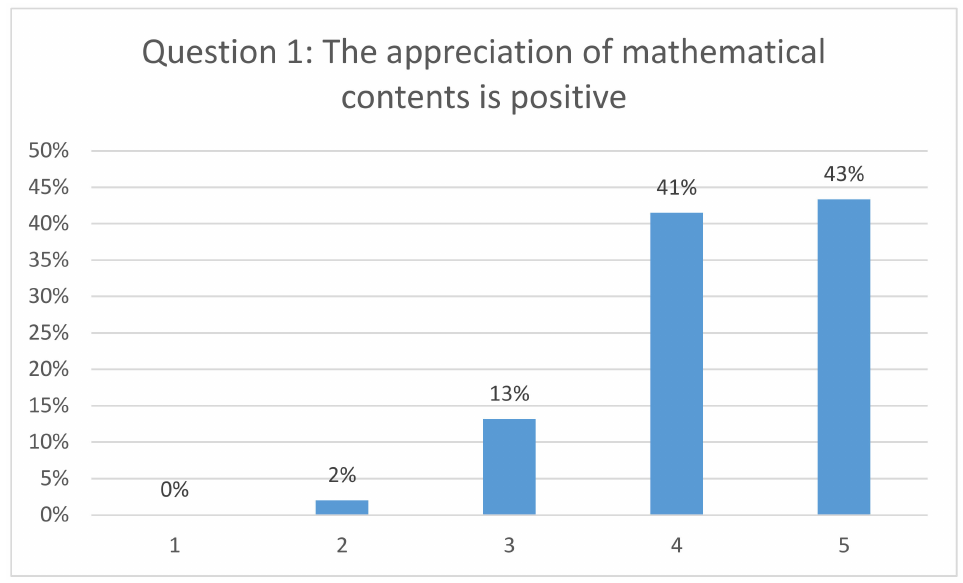
Figure 7. Answers to question 1: the appreciation of mathematical contents is